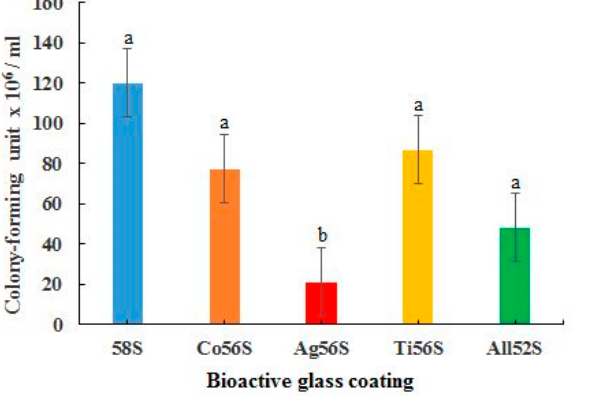
Figure 5. Antibacterial activity against Porphyromonas gingivalis for the bioactive glass coatings. Different letters mean the groups are significantly different ( p < 0.05).